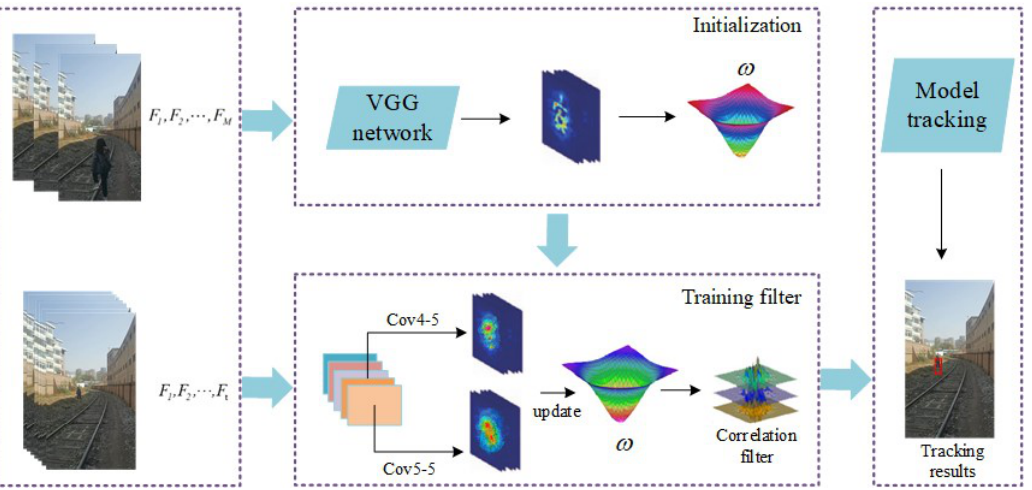
Fig. 1. The algorithm flow of this